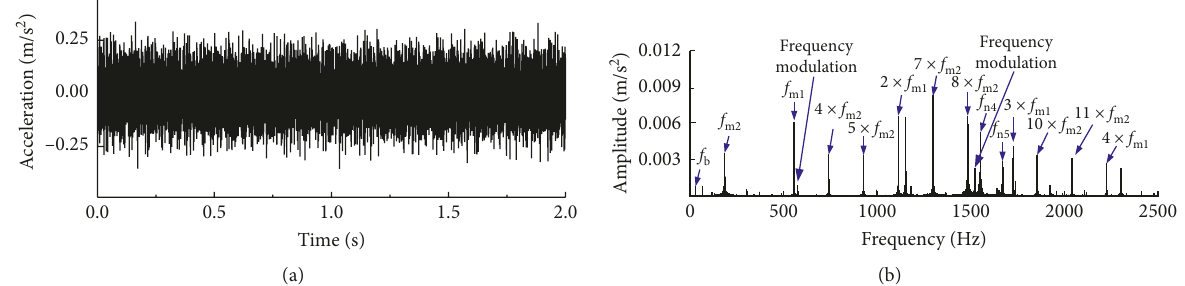
Figure 18: Time- and frequency-domain diagrams of the simulation analysis. (a) Time-domain history of acceleration. (b) Acceleration spectrum.